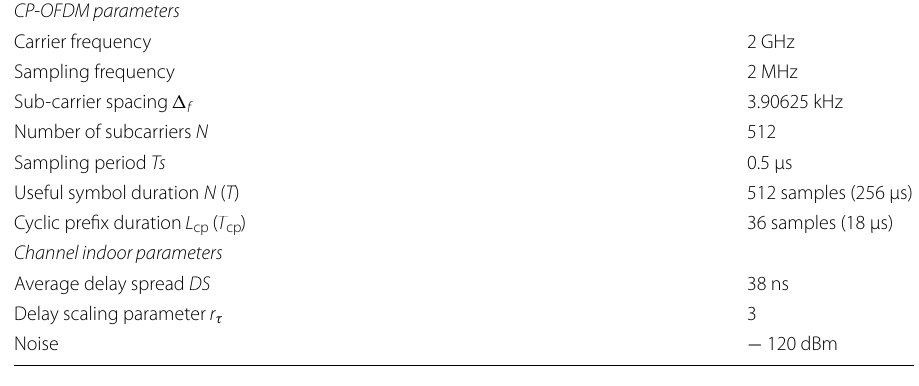
Table 1 Parameters used in simulation CP-OFDM parameters Carrier frequency 2 GHz Sampling frequency 2 MHz Sub-carrier spacing (cid:31)